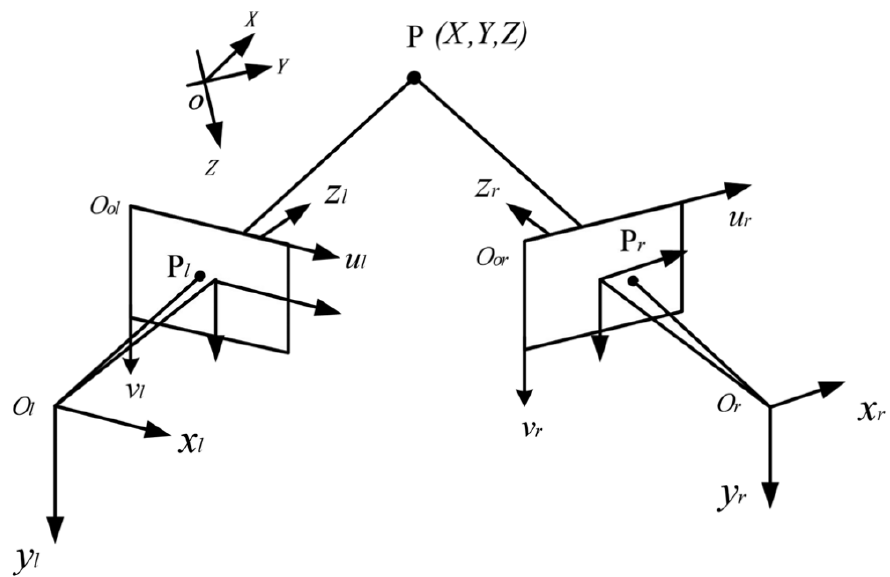
Figure 22. Camera measurement principle [133].